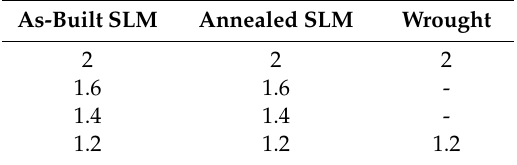
Table 3. Strain amplitudes ε a in (%) of low cycle fatigue (LCF)